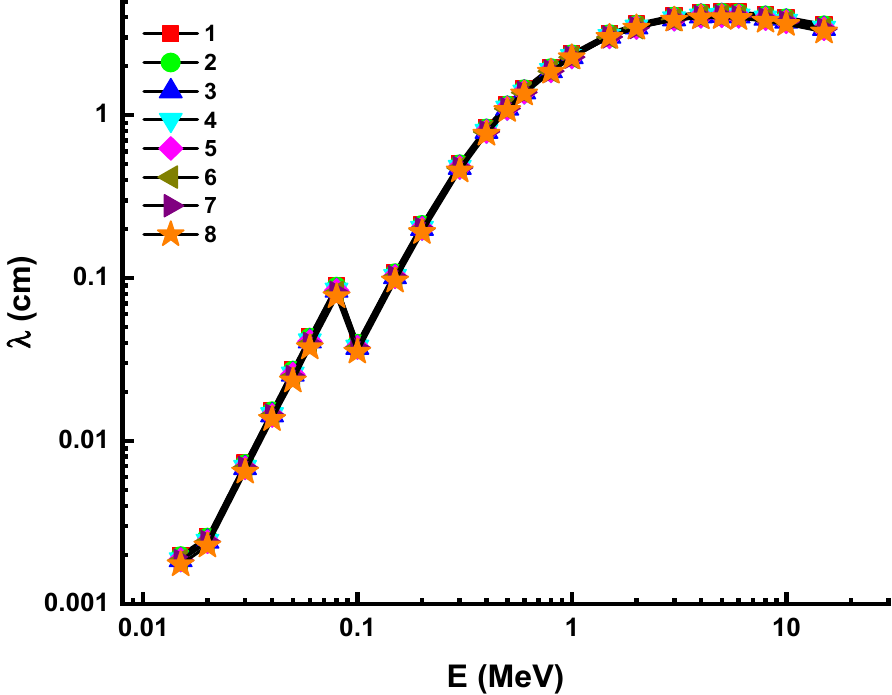
Figure 5. Variation of men free path ( λ ) against photon energy for all glasses. 1—37.5Bi 2 O 3 –62.5B 2 O 3 ;